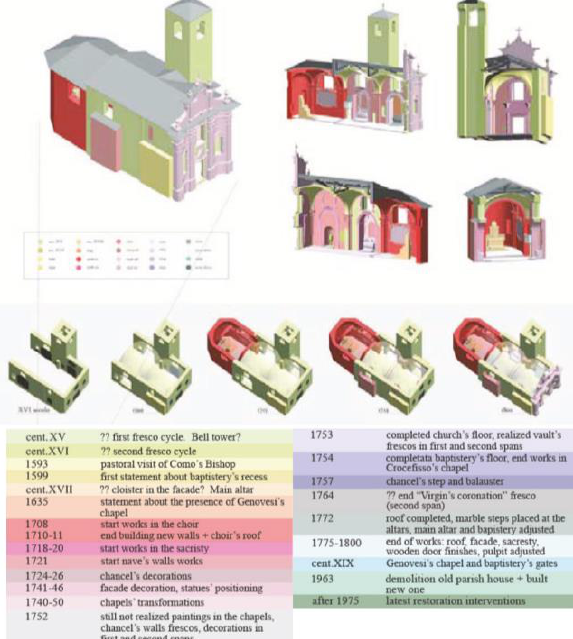
Figure 2: HBIM of the different constructive phases of St. Maria church and its historical transformation. (Brumana et al. ,